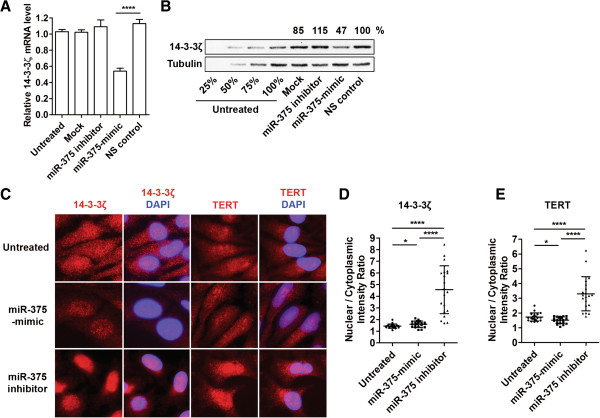
miR-375 modulates TERT nuclear translocation by regulating 14-3-3ζ. (A) Relative endogenous 14-3-3ζ mRNA levels were measured in HeLa cells transfected with miR-375 inhibitor, -mimic, or NS control using qRT-PCR. (B) In parallel, Western Blot analysis measured 14-3-3ζ protein level changes in cells transfected with miR-375 inhibitor, -mimic, or NS control. Tubulin expression was used as an internal control. 25%, 50%, 75%, 100% amounts of untreated cell lysates were included to calibrate the semiquantitative measurement. (C) Indirect immunofluorescence was used to monitor cellular localization of 14-3-3ζ and TERT 48 h post-transfection with miR-375-mimic or inhibitor in HeLa cells. Nuclei were counter-stained with DAPI. (D) Quantification of nuclear/cytoplasmic fluorescence intensities of 14-3-3ζ. (E) Quantification of nuclear/cytoplasmic fluorescence intensities of TERT. Data represents the mean ± SD for nuclear/cytoplasmic fluorescence ratio of 20 cells per image. *p < 0.05, ****p < 0.0001.